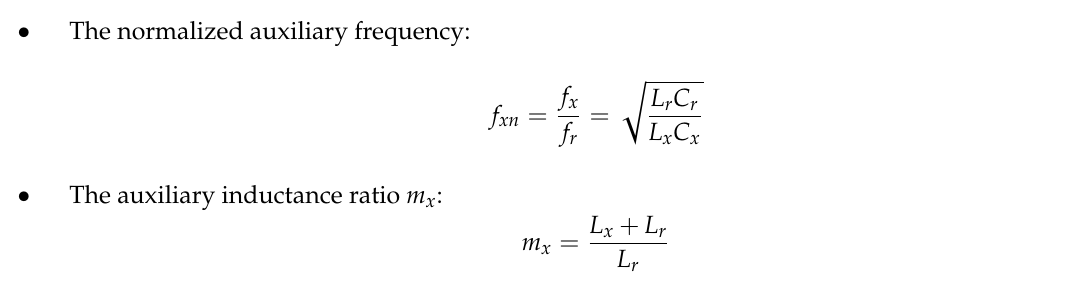
Figure 19. Auxiliary circuit maximum inductance ratio ( 𝑚 (cid:3051) ) design criteria. To avoid DC bias in the unregulated inductor, a DC blocking capacitor is added in series. This creates a secondary resonant tank. As explained previously, the auxiliary circuit behavior is inductive. At resonant frequency, where 𝑓 (cid:3046) = 𝑓 (cid:3045) , then 𝑓 (cid:3051)(cid:3041) ≪ 1 . The voltage in the capacitor is negligible compared to the input square waveform. However, the maximum voltage value should be calculated for design purposes. The auxiliary capacitor voltage shape is a parabola, as shown in Figure 18. The ripple in this capacitor can be calculated using the capacitor equation and integrating the triangular current through the auxiliary circuit: